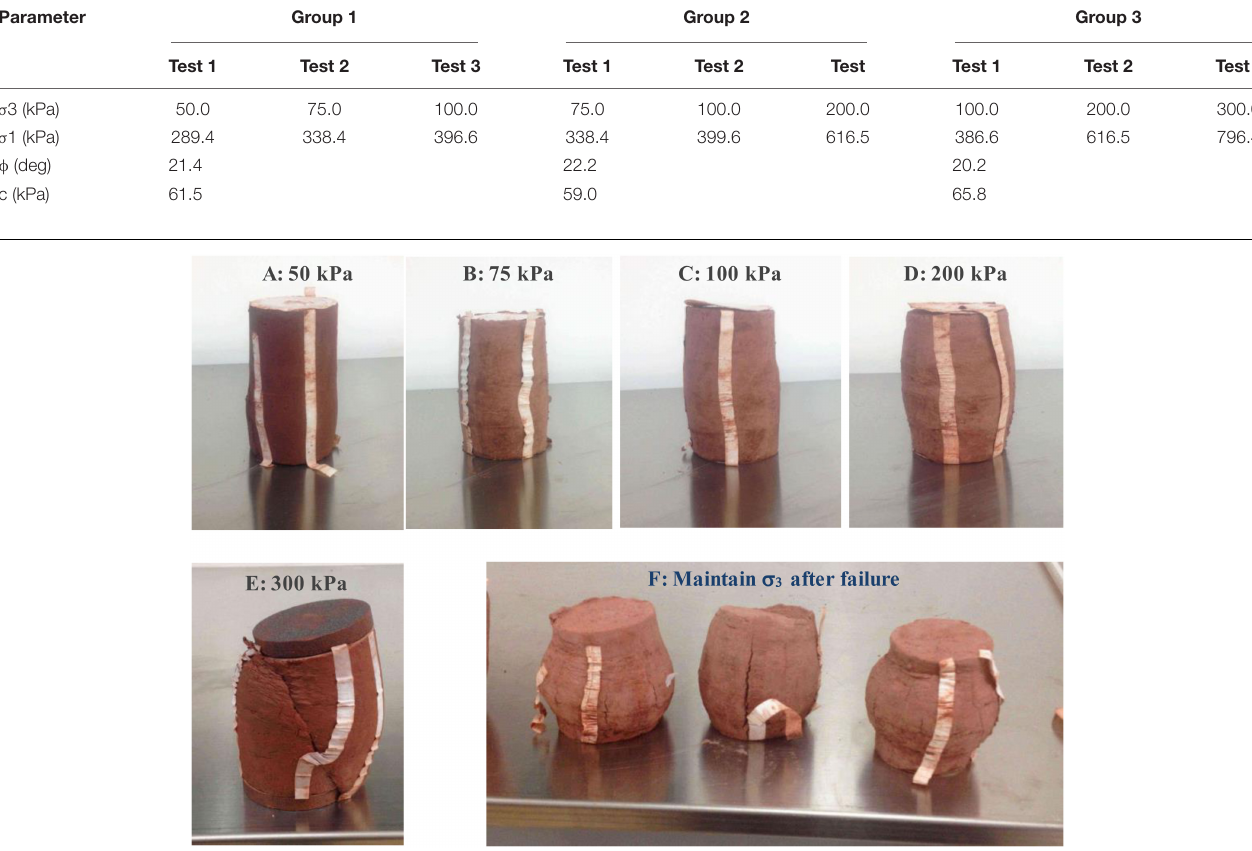
TABLE 3 | Soil strength parameters obtained from the CD triaxial compression tests.